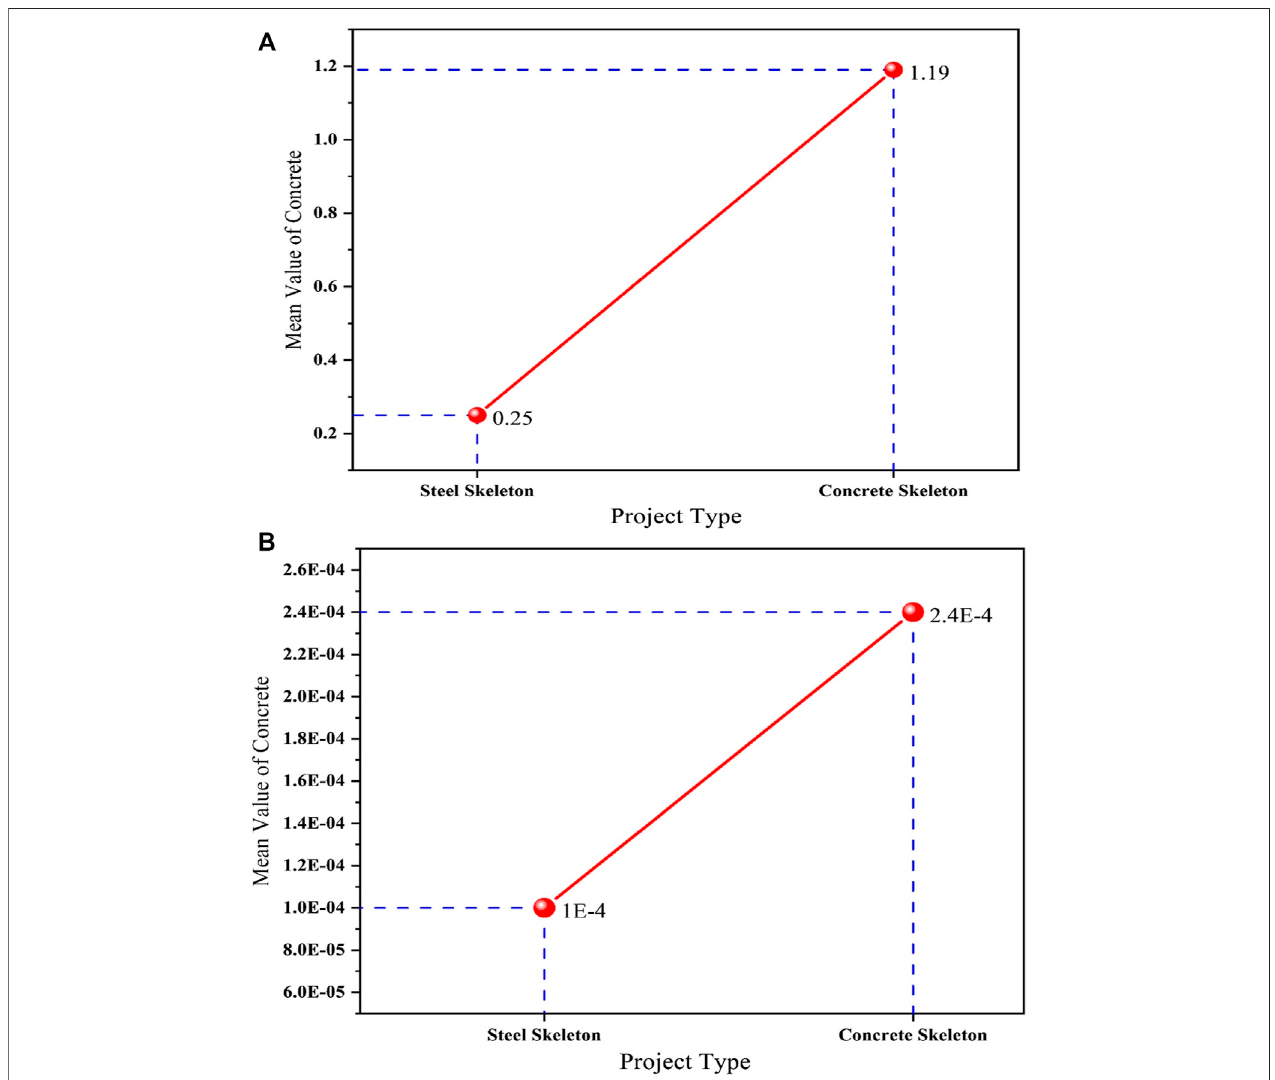
FIGURE 6 | Mean Plot. (A) Total used material. (B) Total generated